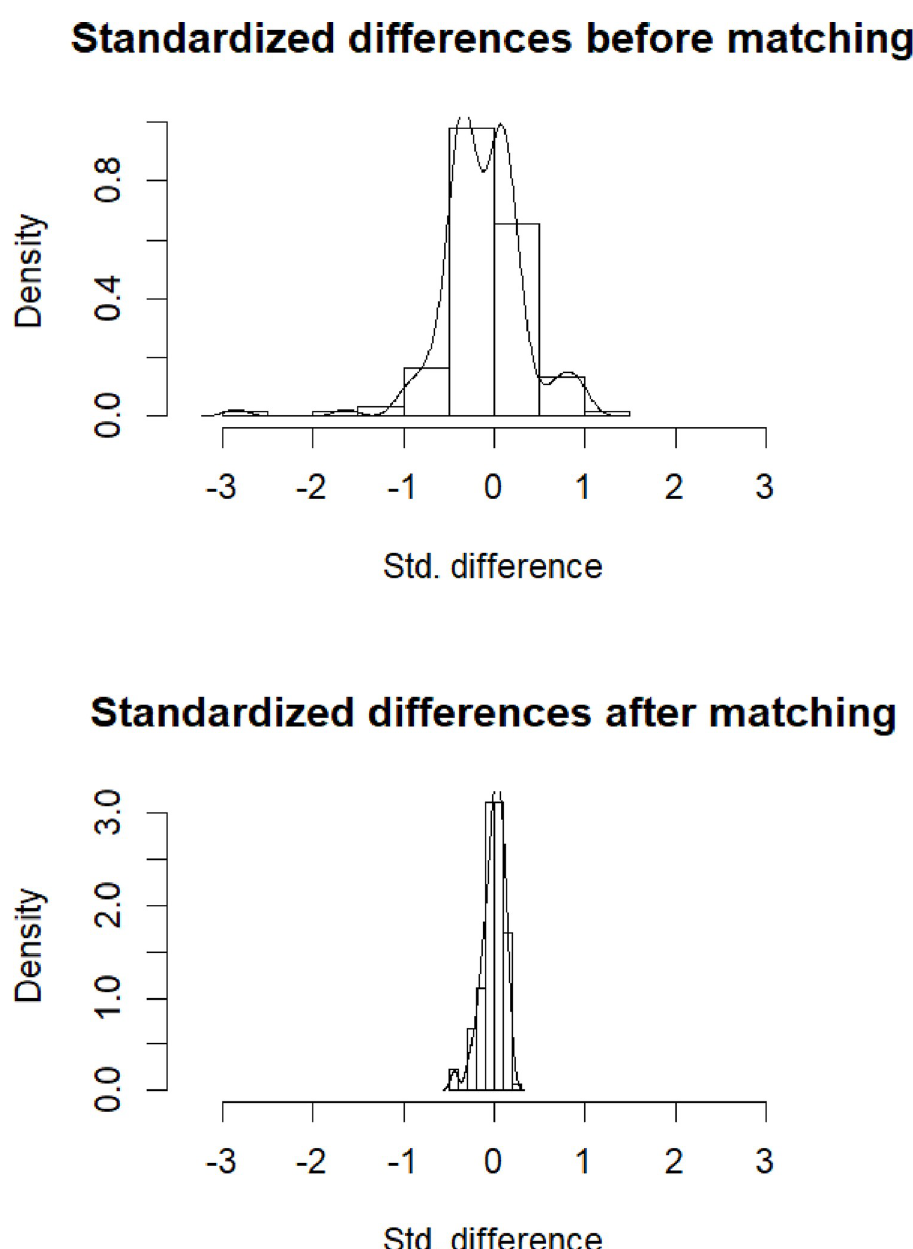
Fig 2. Standardized differences between HCQ/AZI and control group, before (A) and after (B) propensity-score matching.